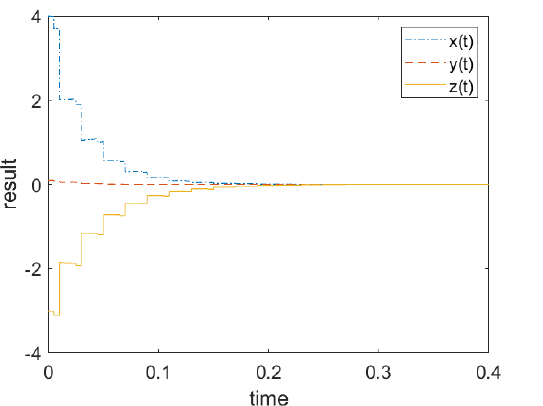
Figure 3. The time responding curves of system (57) with uncertain sandwich control and impulse time